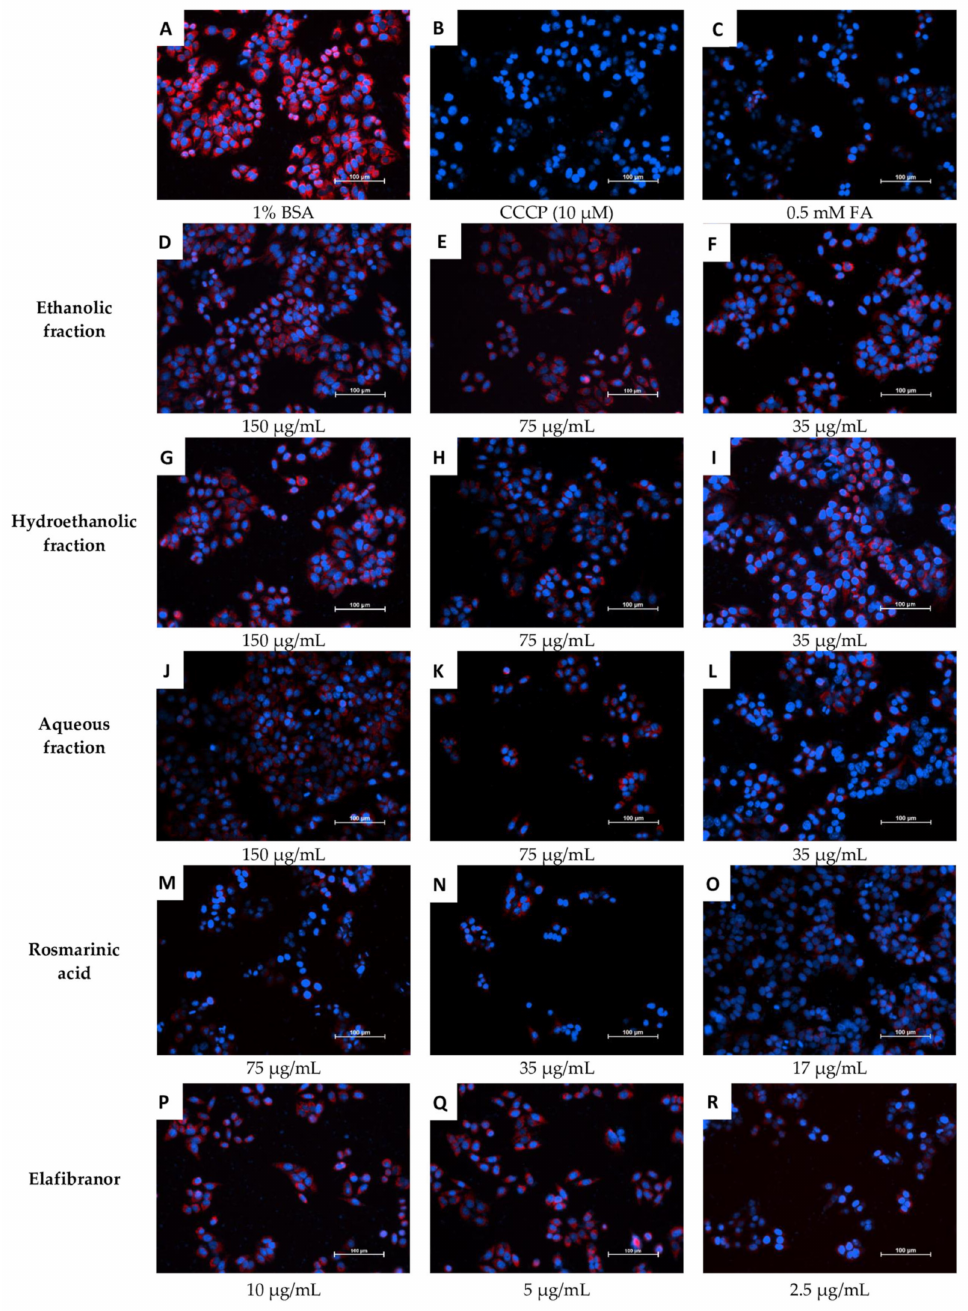
Figure 12. Microscopic examination of the effects of O. aristatus fractions on the mitochondrial membrane potential. The red colour is the TMRM stain (TRITC filter), and the blue is Hoechst 33342 (DAPI filter) as a nuclear counterstain. BSA: Bovine Serum Albumin, CCCP: Carbonyl Cyanide Chlorophenylhydrazone, FA: Fatty Acids Mixture. The scale bar is 100 µ m (20 ×